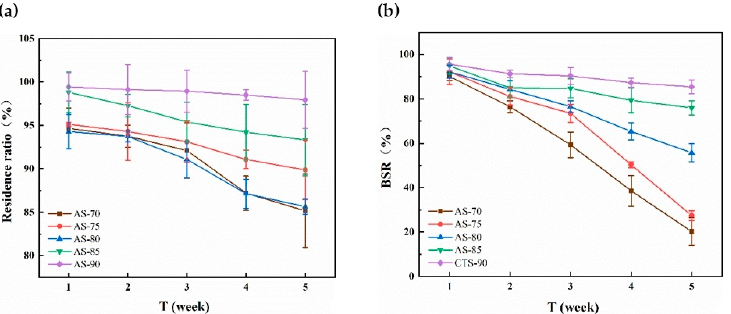
Figure 4. Effects of chitosan’s DD on residual ratio ( a ) and BSR ( b ) of its monofilament with enzymatic hydrolysis.